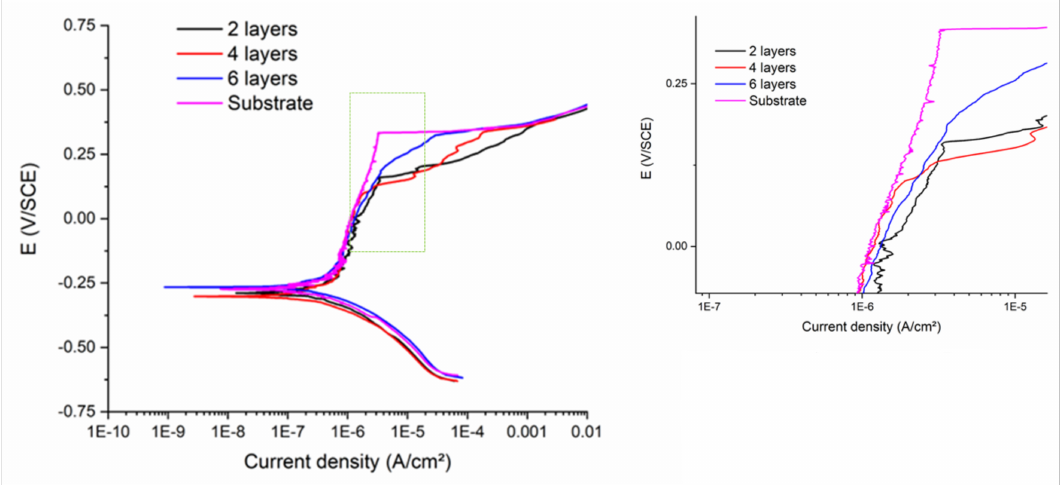
Figure 8. Potential dynamic polarization curves in 3.5% NaCl water solution at 25 ◦